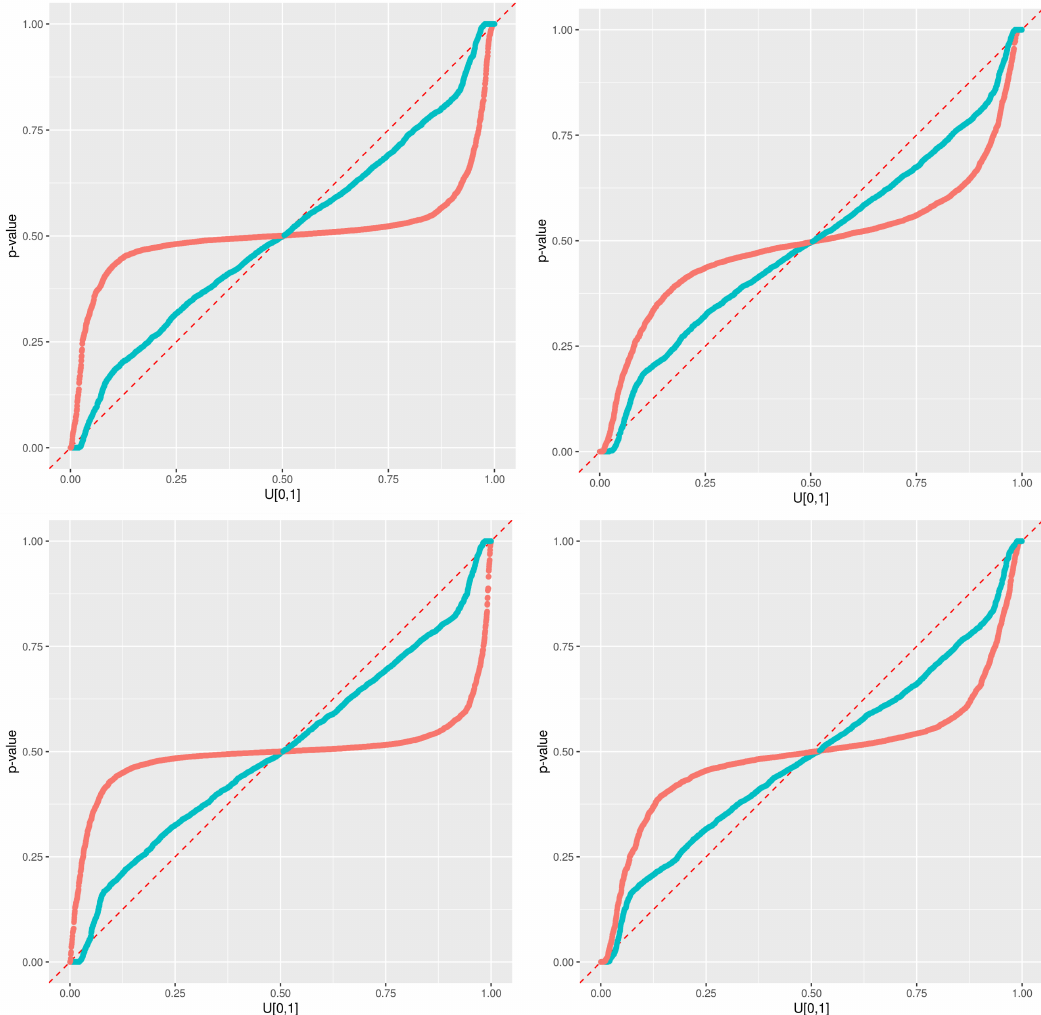
Figure 16. Predictive qq-plot for the prediction period with dataset B and subset type 2. The different methods are colored in red for Wager 2014 and blue for Lu